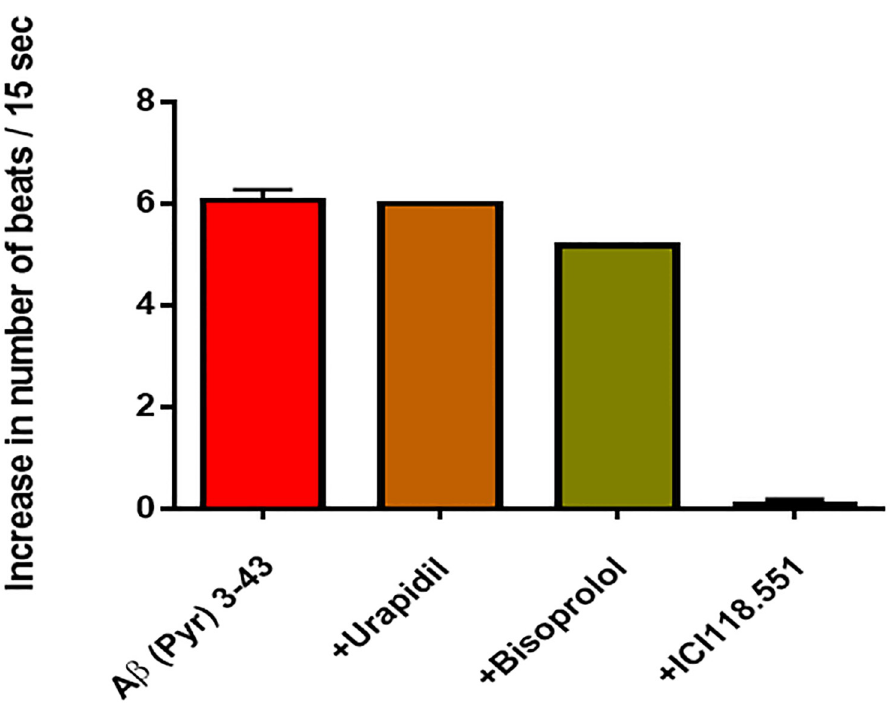
Fig 2. Functional effect realized via the β 2 adrenoceptor by the truncated A β peptide A β -[PYR]3–43 (n = 5): This effect was blocked by ICI 118.551 (n-4, p<0.001), yet not by the β 1 adrenoceptor antagonist bisoprolol or the α 1-adrenergic antagonist urapidil.